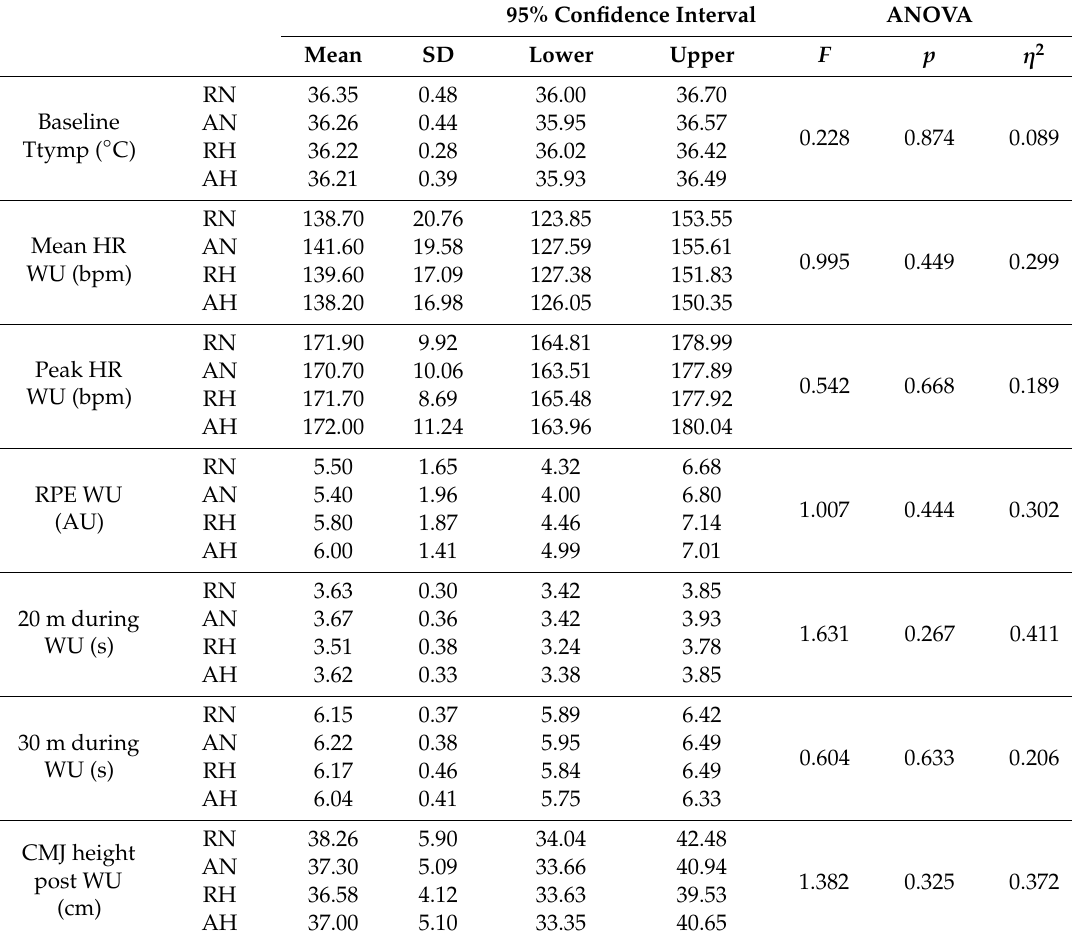
Table 1. Results during warm-up and post-warm up in the four strategies